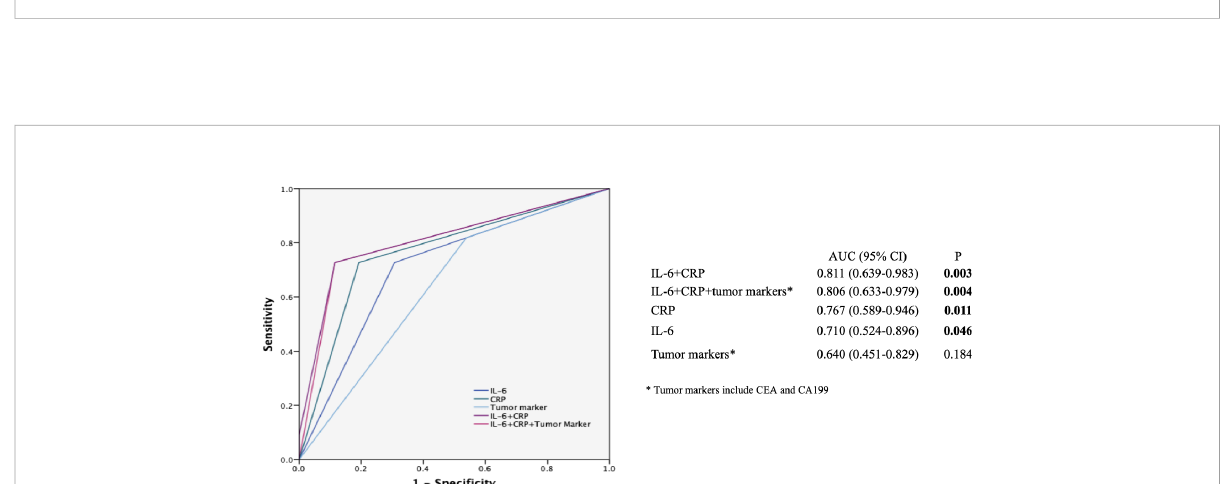
FIGURE 5 Receiver operating characteristic (ROC) curves for predicting the ef fi cacy of the mFOLFIRINOX regimen. ROC analyses of the prediction of the ef fi cacy of mFOLFIRINOX using the in fl ammatory marker model, the tumor marker model, and the combined in fl ammatory and tumor marker model. The ROC analysis showed that the combination of IL-6 and CRP (AUC: 0.811, 95% CI: 0.639-0.983, P = 0.003) had a higher AUC compared with CRP alone (AUC: 0.767, 95% CI: 0.589-0.946, P = 0.011), IL-6 alone (AUC: 0.710, 95% CI: 0.524-0.896, P = 0.046), tumor markers (AUC: 0.640, 95% CI: 0.451-0.829. P = 0.184) alone, and their combination (IL-6 + CRP + tumor markers, AUC: 0. 806, 95% CI: 0.633- 0.979, P = 0.004). AUC, Area under the curve. The symbol * is the annotation of tumor